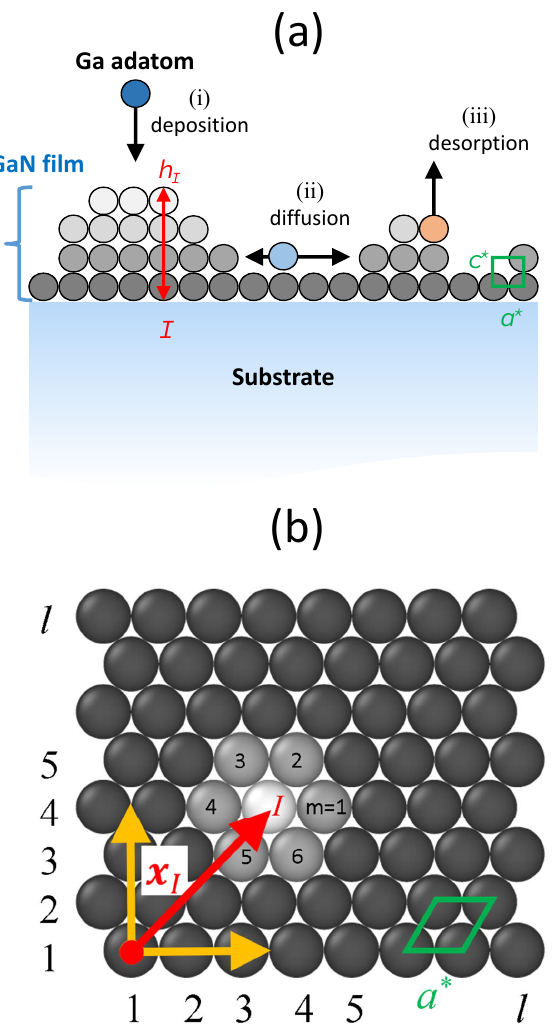
Figure 1. ( a ) Cross section of the system under study. The actual domain of simulation is the indicated GaN film, modeled as a set of adatoms located at predefined lattice sites, and represented here as spheres in hexagonal unit cells of parameters a ∗ and c ∗ . The in-plane sites are labeled by integers I , and the corresponding local heights are denoted by h I (see text). Also sketched are the possible processes that a given adatom can experience: (i) deposition, (ii) diffusion, and (iii) desorption. ( b ) Top view of the GaN film, with indication of the 2D hexagonal lattice, and illustration of the possible diffusion jumps that an adatom at x I can